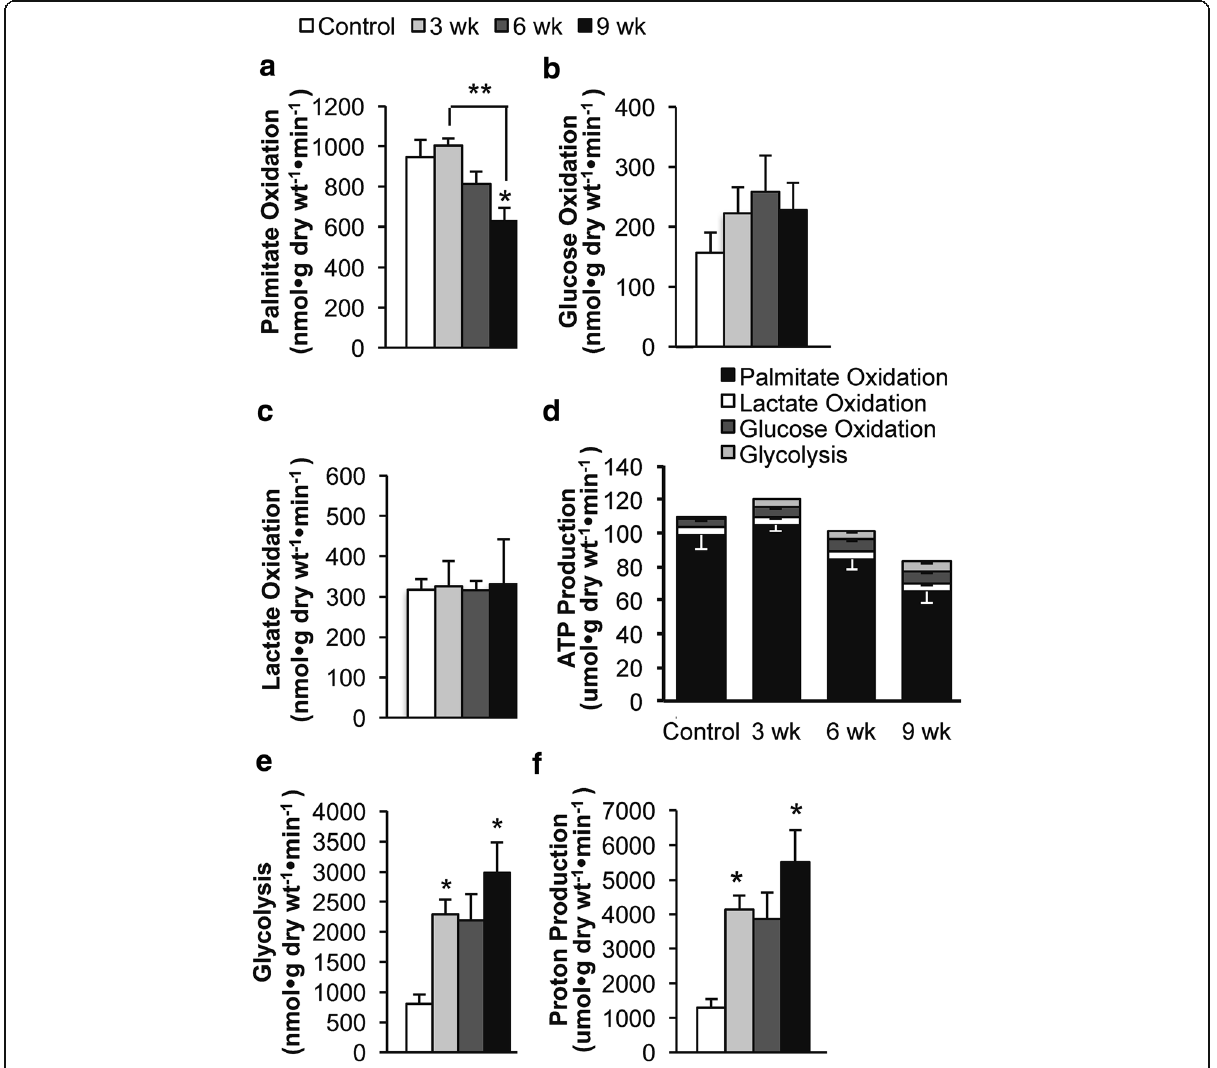
Fig. 2 Time dependent effects of a high salt diet (HSD) on palmitate oxidation, glucose oxidation, glycolysis, and lactate oxidation in Dahl salt-sensitive rat hearts. a Palmitate oxidation, ( b ) Glucose oxidation, ( c ) Lactate oxidation, ( d ) ATP production, ( e ) Glycolysis, and ( f ) Proton production were measured in hearts from Dahl salt-sensitive rats fed a low salt diet, 0.3% NaCl (Control) or a HSD, 8% NaCl, for 3, 6, or 9 weeks. Energy metabolic rates were assessed in isolated working hearts. Proton production was calculated based on glycolysis and glucose oxidation rates. Contribution to ATP production was calculated from the metabolic rates assessed using the isolated working heart perfusion in Dahl salt-sensitive rats. n =3 – 5 * p <0.05 compared to Control.